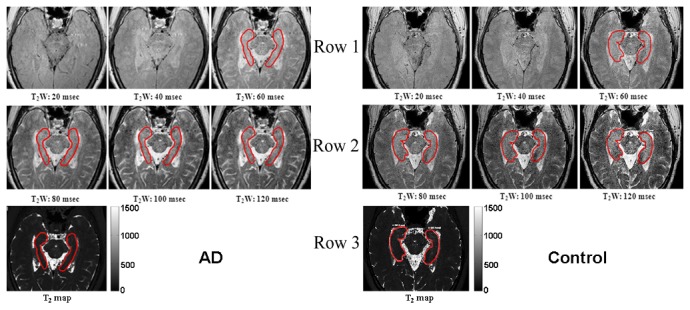
T2-weighted images at various echo time-points and resultant T2-map.Row 1 & Row 2 consist of six T2-weighted images, taken at echo times of 20, 40, 60, 80, 100, and 120 ms, covering the entire hippocampus of an AD patient and an elderly control. The single image in Row 3 is the corresponding T2 map. The bilateral hippocampal atrophy was visually found accompanied with a varied degree of decreased T2 values (or increased R2 values) in the AD patient. Illustration of the ROI selection on the representative spin-echo images (TE = 60, 80, 100 and 120 milliseconds) of a patient with AD and an elderly control. The hippocampal region for which T2 data were acquired is shown as representative regions of interest. Note: ROIs required include the hippocampal contours to be as large as possible but not involving its boundaries, and avoiding visible cystic areas and CSF in the hippocampal fissure.